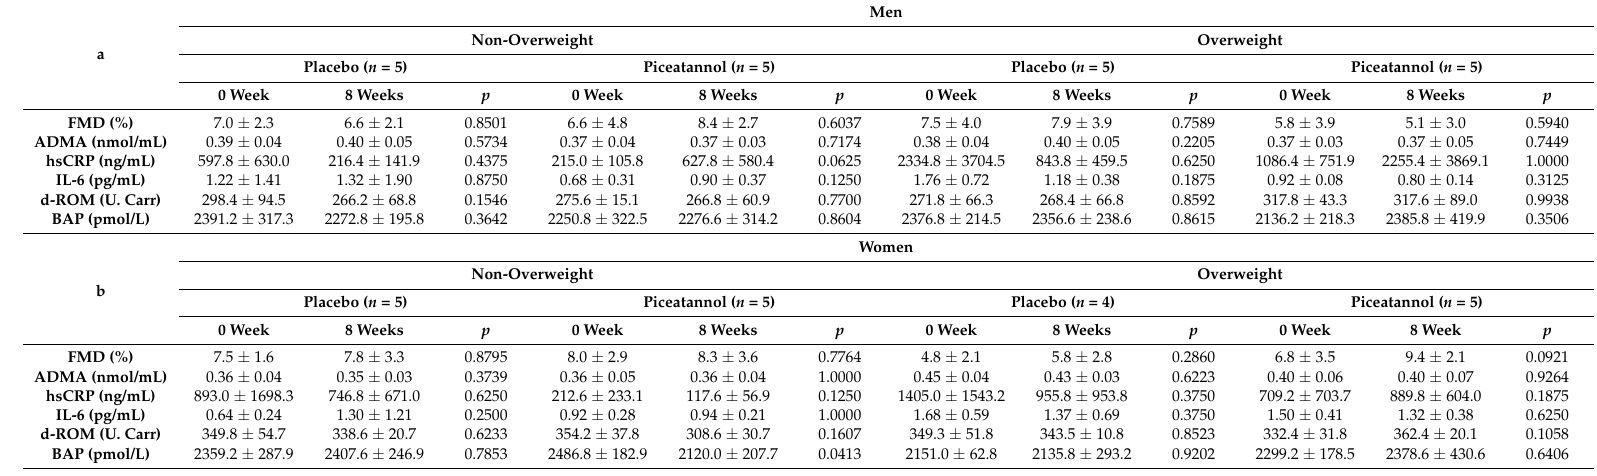
Table 5. Flow Mediated Dilation (FMD), asymmetric dimethylarginine (ADMA), high sensitive C-reactive protein (hsCRP), interleukin-6 (IL-6), diacron reactive oxygen metabolite (dROM) and biological antioxidant potential (BAP) at baseline and after 8 weeks of placebo or piceatannol supplementation (a: men, b: